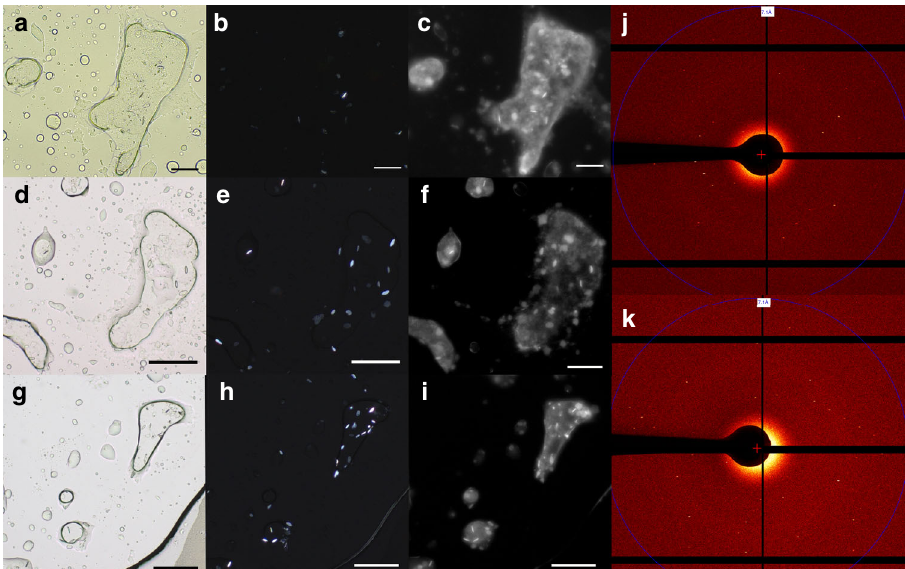
Fig. 4 GLIC protein crystals grown in meso using DSPG – MP. GLIC protein crystals were grown in meso at 20 °C using 5 wt% DSPG/MP ( a – c ), 8 wt% DSPG/MP ( d – f ), and 10 wt% DSPG/MP ( g – i ) swollen mesophase systems (2:8 lipid to protein ratio), with crystal diffraction patterns ( j ) and ( k ) from the SLS crystallography beamline for crystal grown using 10 wt% DSPG/MP mesophase system. Crystallization conditions were 0.2 M (NH 4 )SO 4 , 0.02 M NaCl, 0.02 M Na Act 4 pH, 33% v/v PEG200. GLIC protein crystals are shown here under bright fi eld ( a , d , g ), cross-polarized ( b , e , h ), and UV fl uorescence ( c , f , i ) microscope at day 7. Scale bar is 100 µ m on panels a – c and 200 µ m on panel d –